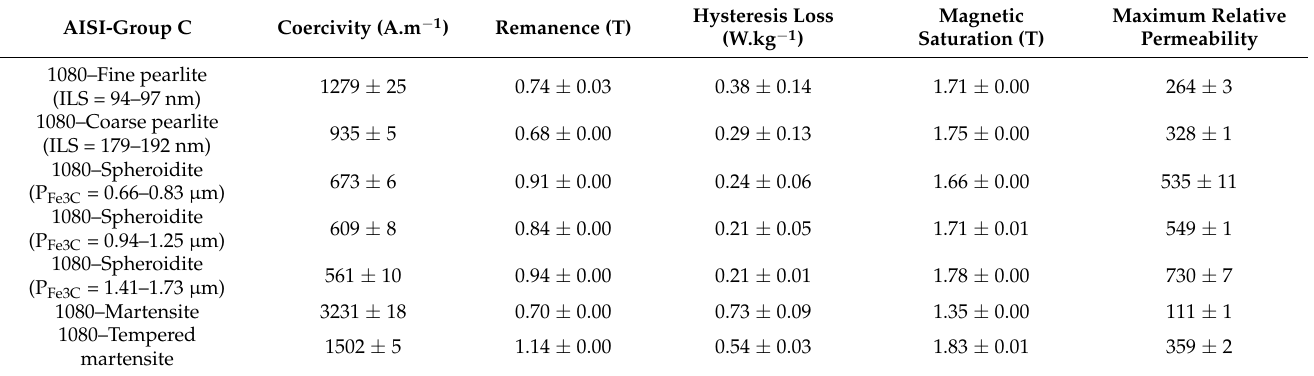
Table 8. Magnetic properties of the various microstructures of group C obtained from AISI 1080 steels.